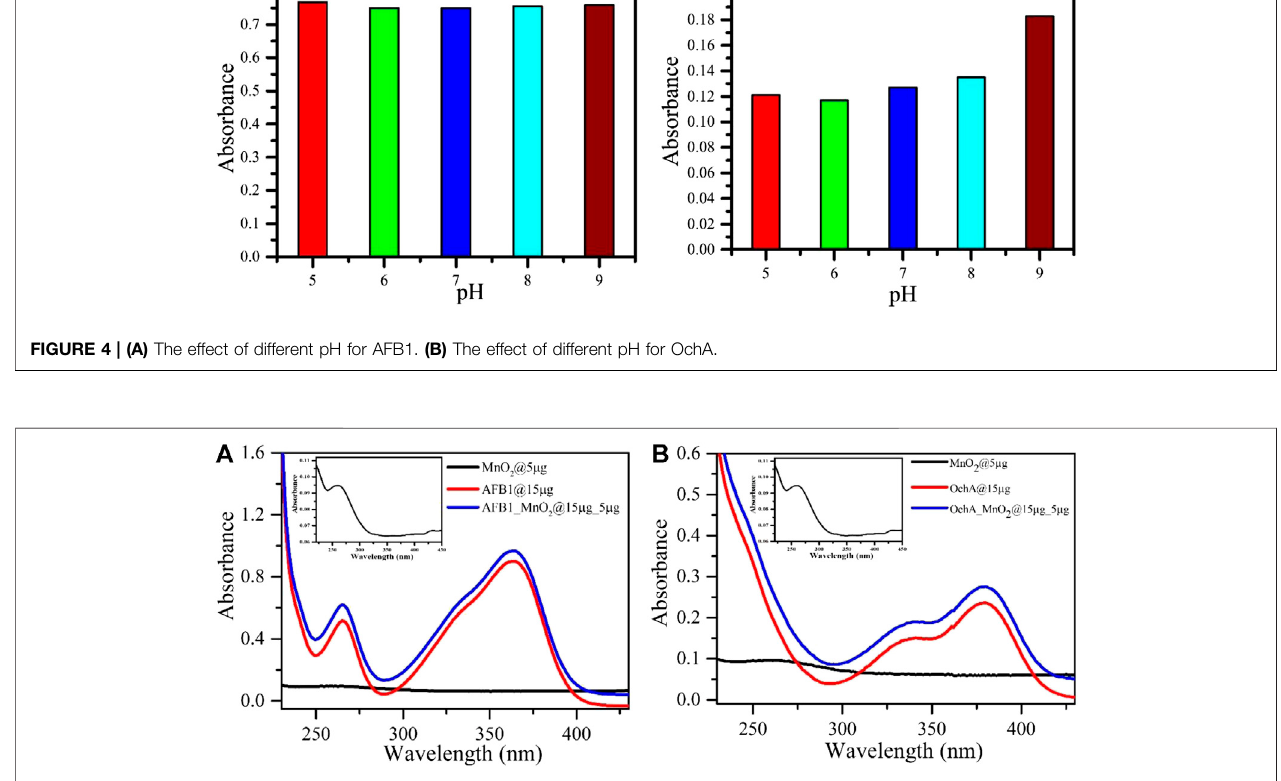
wavelength broad peak shows the major one, as shown in Figure 5B . The absorption intensities of both AFB1 and OchA were increased, with the addition of MnO 2 nps. This increase in the absorption peak of both toxins in the presence of MnO 2 nps indicates the interaction with MnO 2 nps.